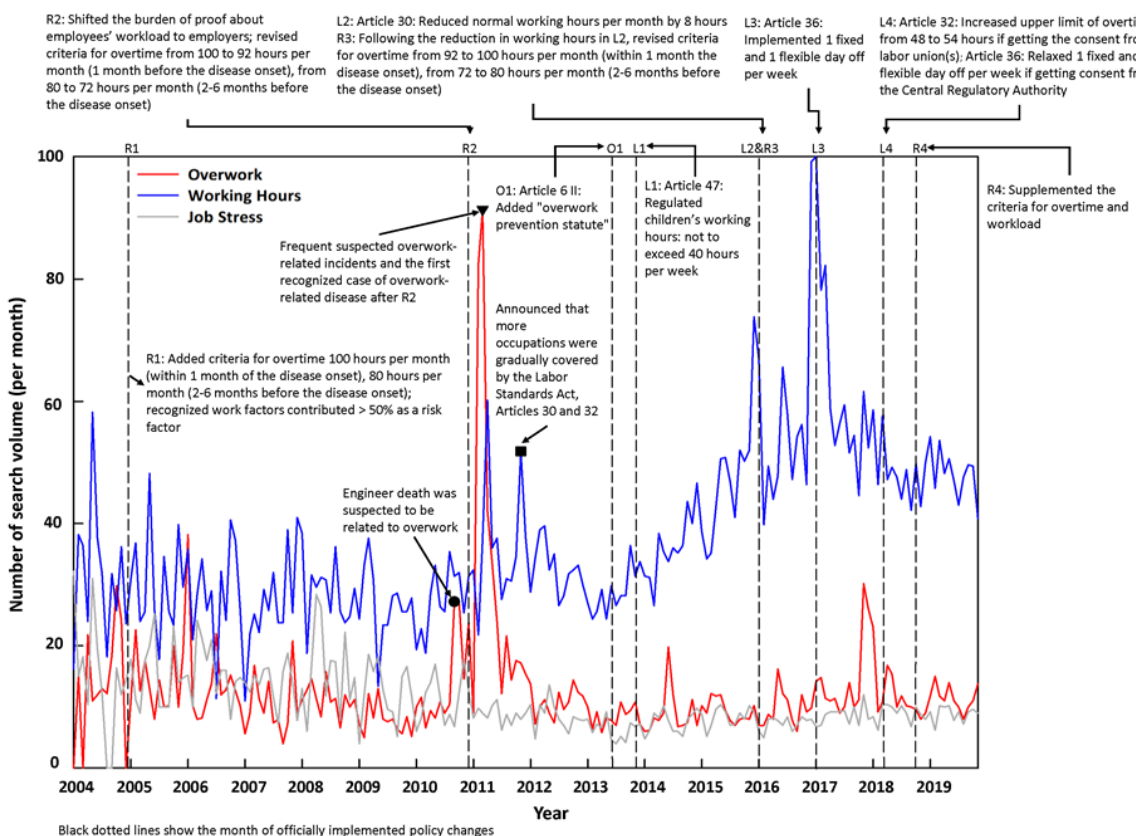
Figure 2. Policy changes and search volume trends for working hours, overwork, and job stress from January 2004 to November